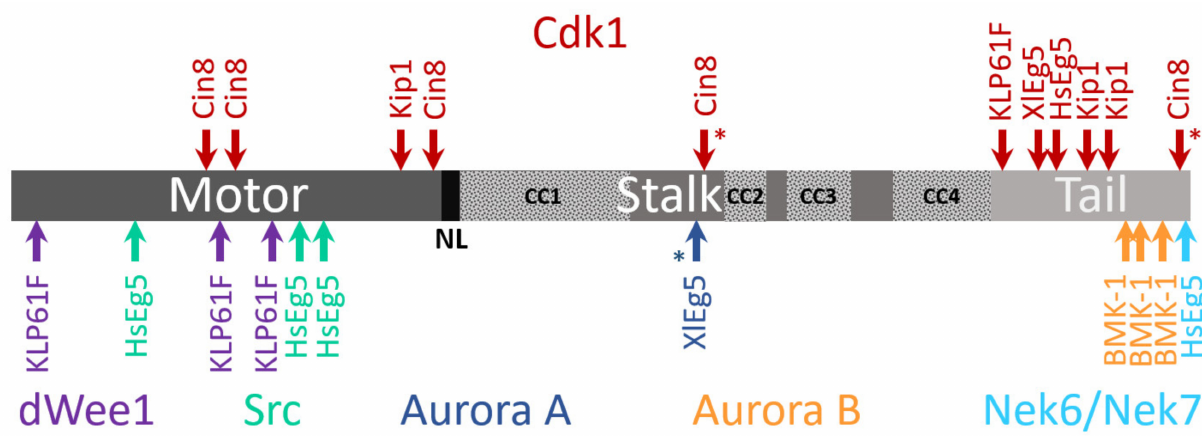
Figure 3. Schematic presentation of phosphorylation sites within kinesin-5 motor sequences. Motor domain, neck linker (NL), the stalk containing putative coiled-coil (CC) regions (dotted patterns), and the tail are indicated by shades of gray. Asterisks indicate an unidentified function for the phosphorylation site. For the different phosphorylation sites, the corresponding kinases (color coded) are indicated at the top (Cdk1) or bottom (other kinases). Location of the different phosphorylation sites within the amino-acid sequence is scaled according to the length of a particular kinesin-5 motor protein. Top: Phosphorylation sites for Cdk1 [17,18,31,56–58,61–66]; Bottom: phosphorylation sites for dWee1 [67], Src [68], Aurora A [69], Aurora B [64,70], and Nek6/Nek7